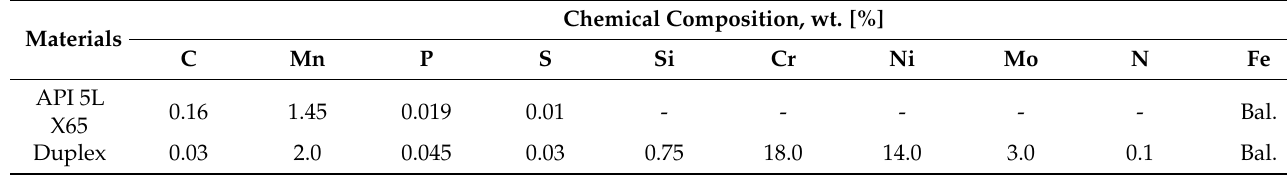
Table 1. Chemical composition of applied materials (API 5L X65, Duplex).